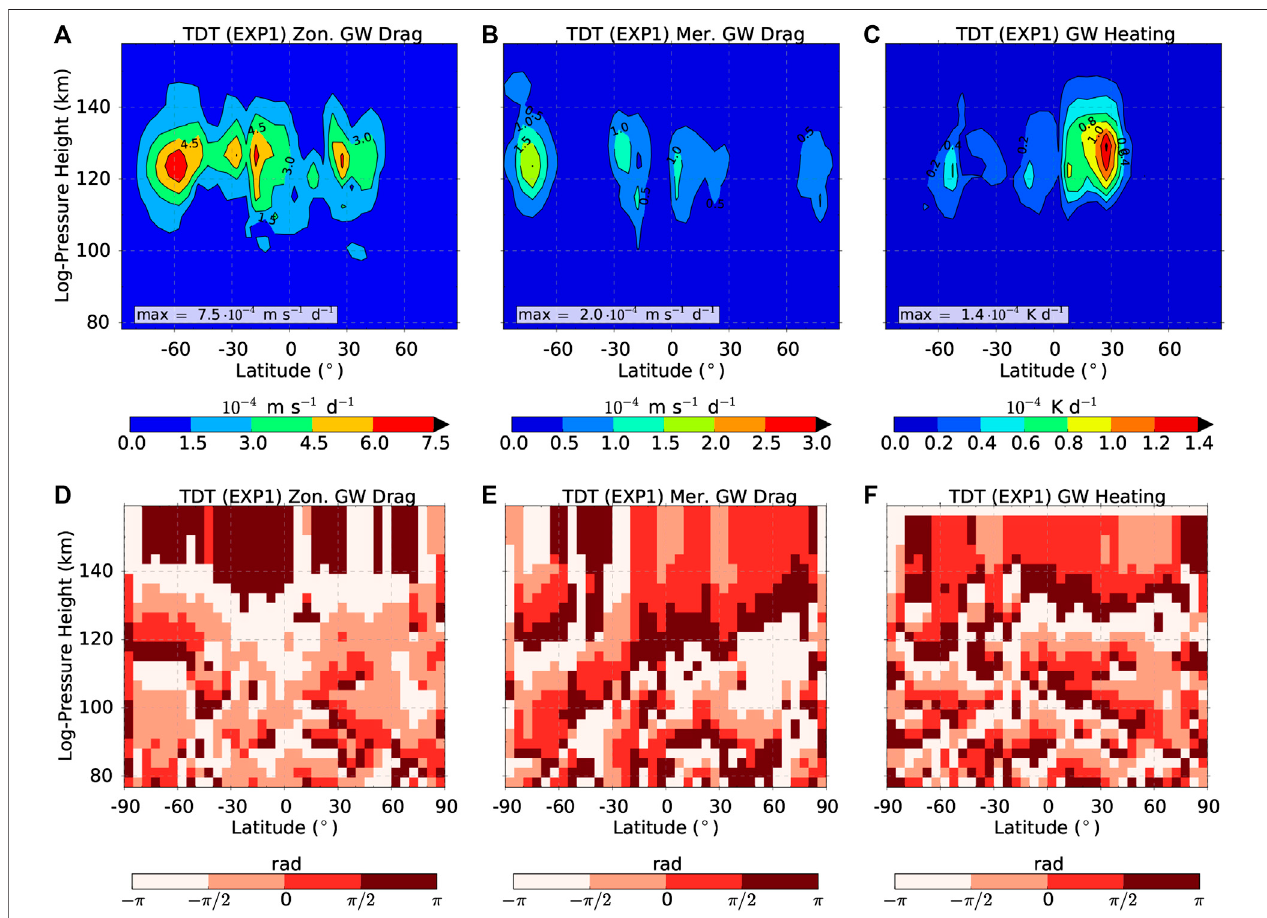
FIGURE9| Sameas Figure8 butforTDTamplitudesof (A) zonalGWdrag(inm s − 1 d − 1 ), (B) meridionalGWdrag(inm s − 1 d − 1 ), (C) heatingduetoGWs(inK d − 1 ), and (D – F) corresponding phases (in